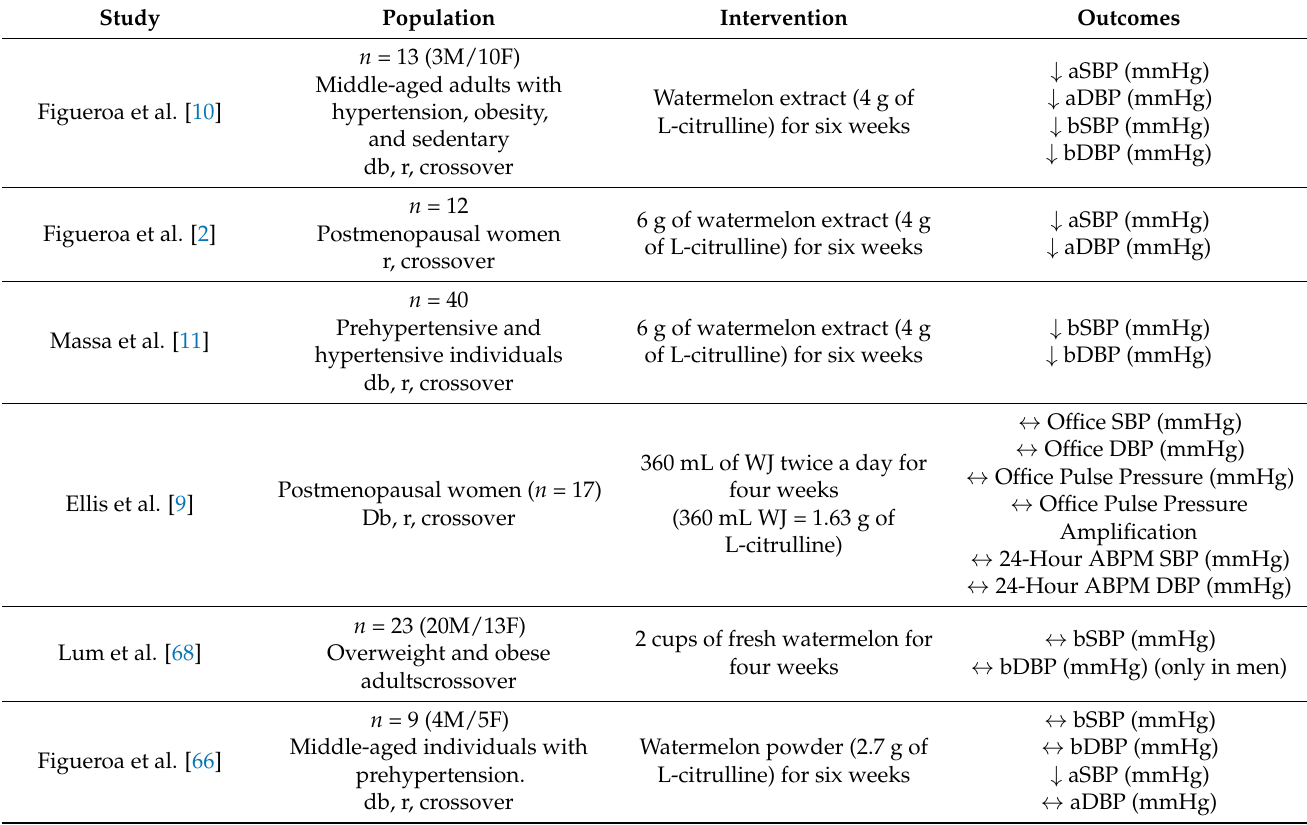
Table 3. Summary of the studies that evaluated the effect of watermelon ingestion on blood